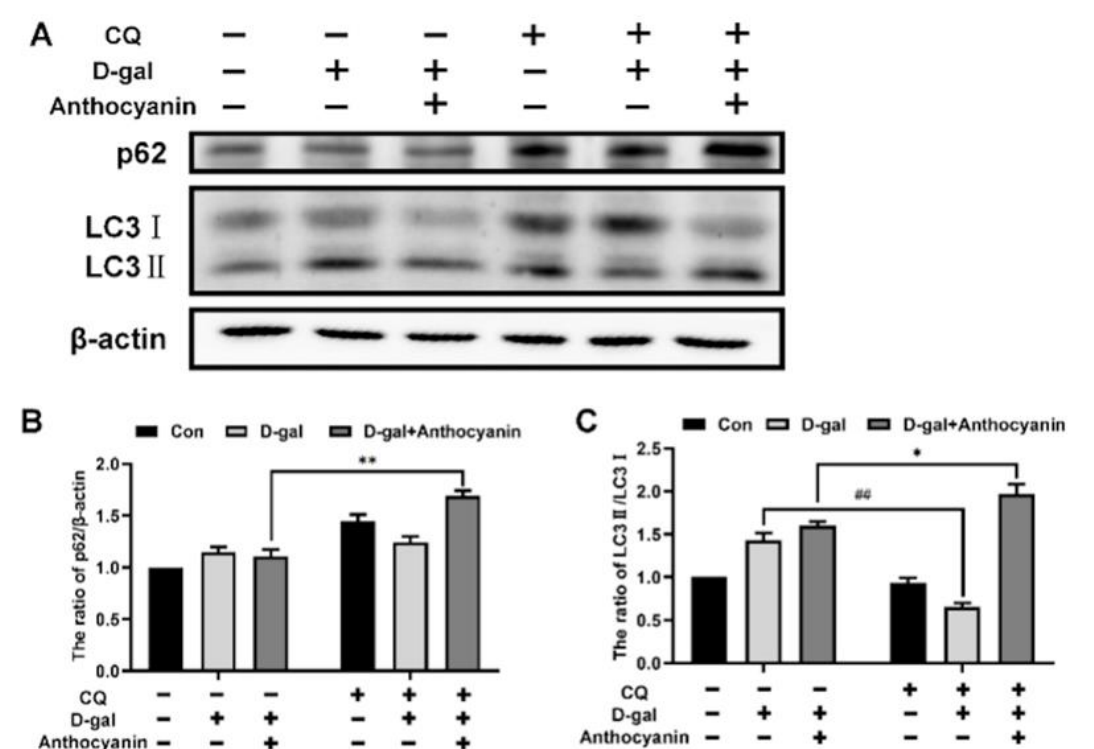
Figure 6. Anthocyanin increased autophagic flux in senescent cells induced by D-galactose. ( A ) Cells were treated with 40 mM D-galactose alone or in combination with 40 μg/mL anthocyanin and 10 µ g/mL CQ for 72 h, and the expressions of p62, LC3II/I were measured using western blot. ( B , C ) The quantification of protein expressions. Data are presented as mean ± SD, n = 3. * p < 0.05, ** p < 0.01, ## p < 0.01.